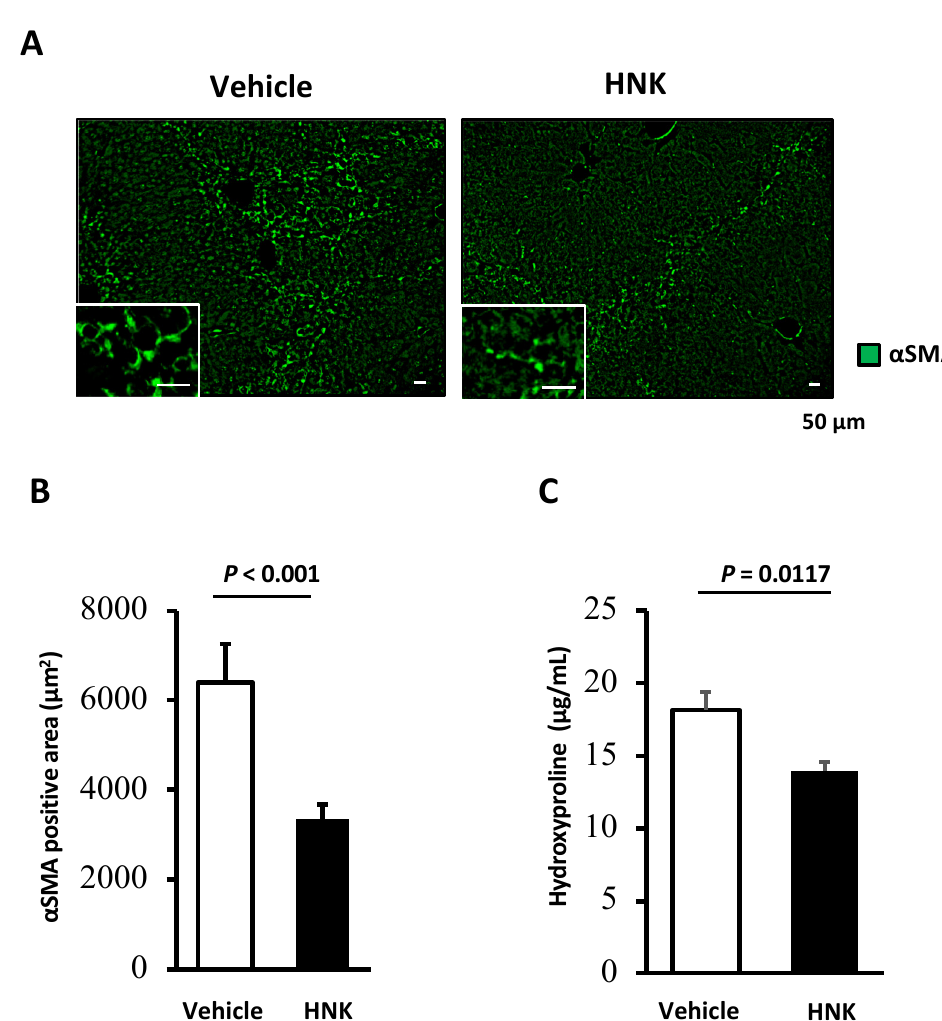
Figure 2. HNK treatment suppresses HSC activation in the livers of mice treated with CCl 4 . Fibrogenesis in mice treated with CCl 4 with HNK ( n = 4 per group) were assessed by immunofluorescence (IF) and hydroxyproline assays. ( A ) α -Smooth muscle actin ( α SMA) protein (Green). ( B ) α SMA positive area ( µ m 2 ) quantified by BZ-X800 Analyzer. ( C ) The results of the hydroxyproline assay. Scale bars represent 200 µ m. All graphs represent the mean ±